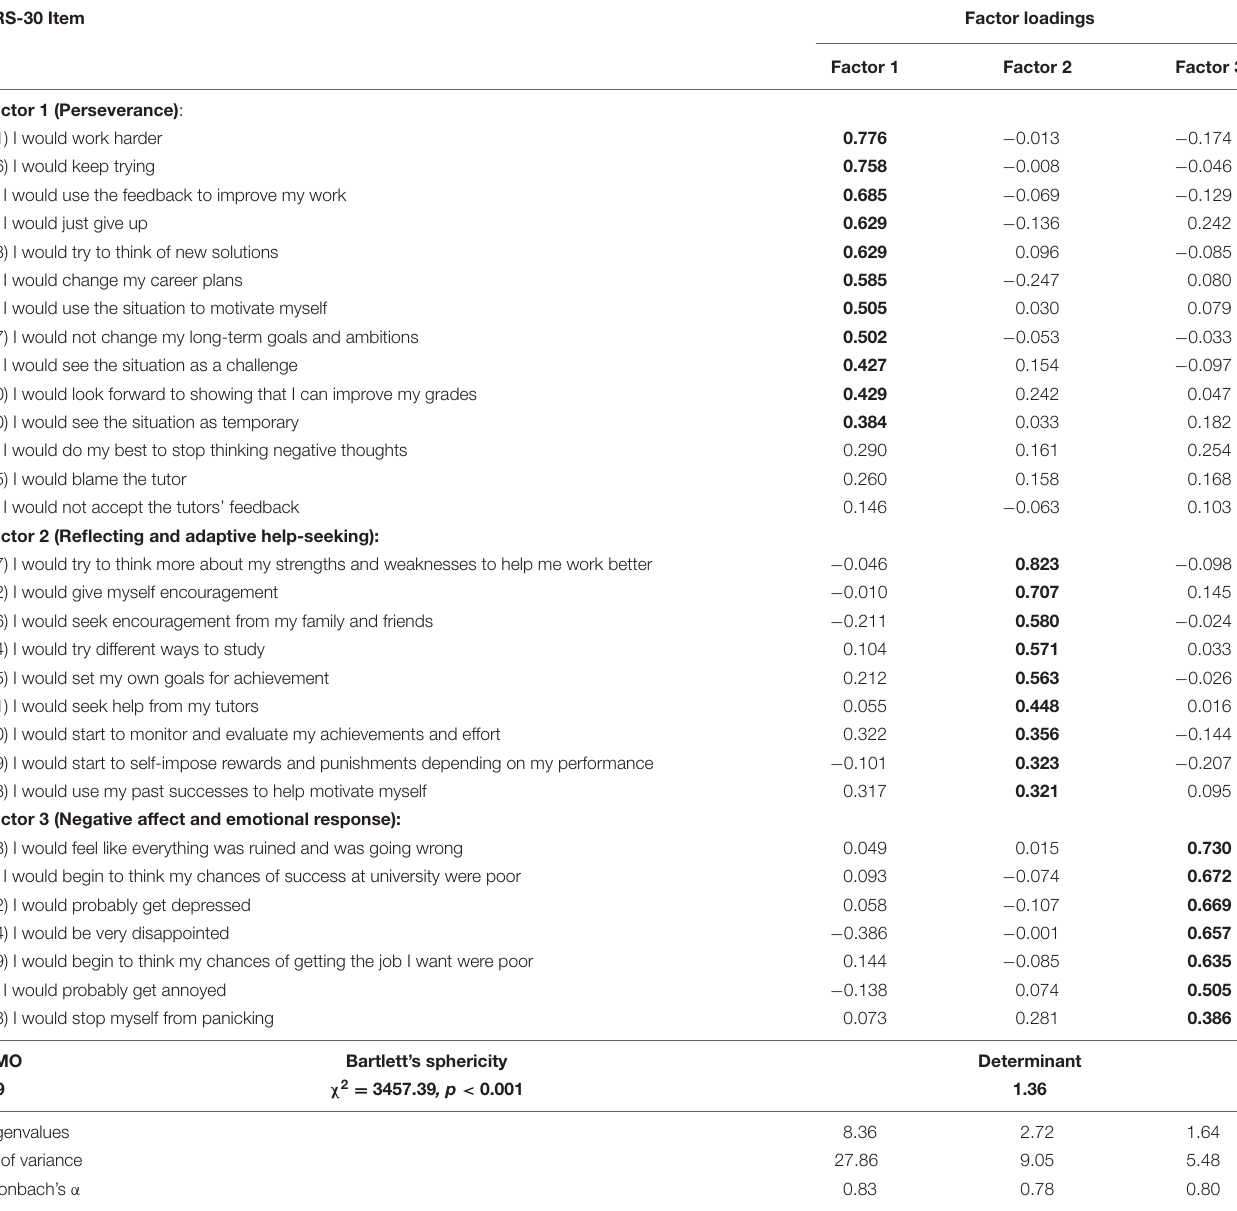
TABLE 3 | Maximum likelihood estimates of the oblique (promax) rotated factor loadings for the ARS-30. ARS-30